Question: According to this chart, does the measure grow or shrink?
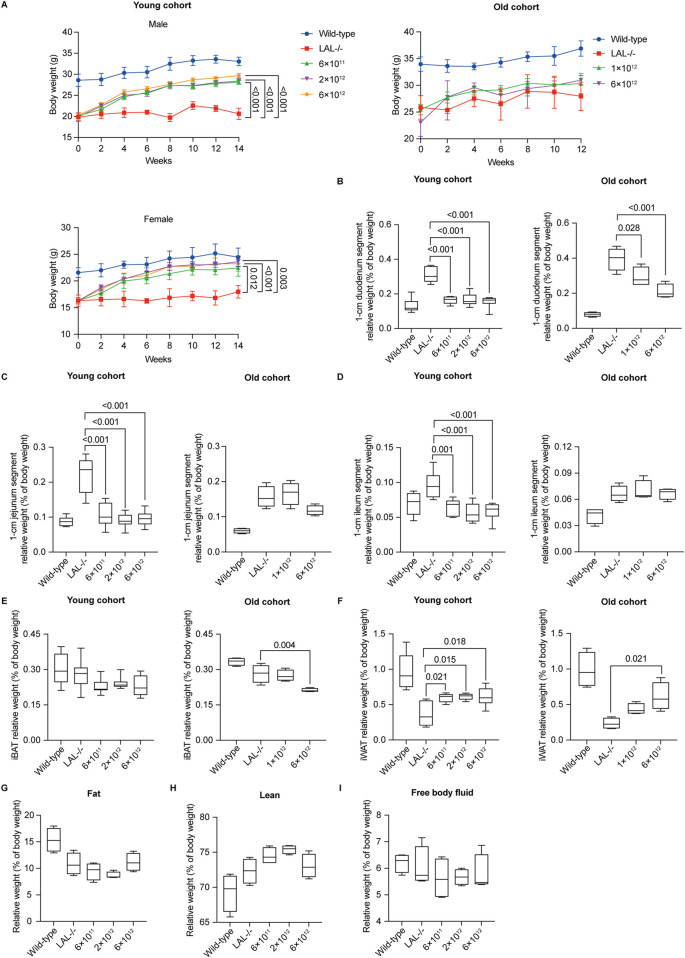
Answer: increasing